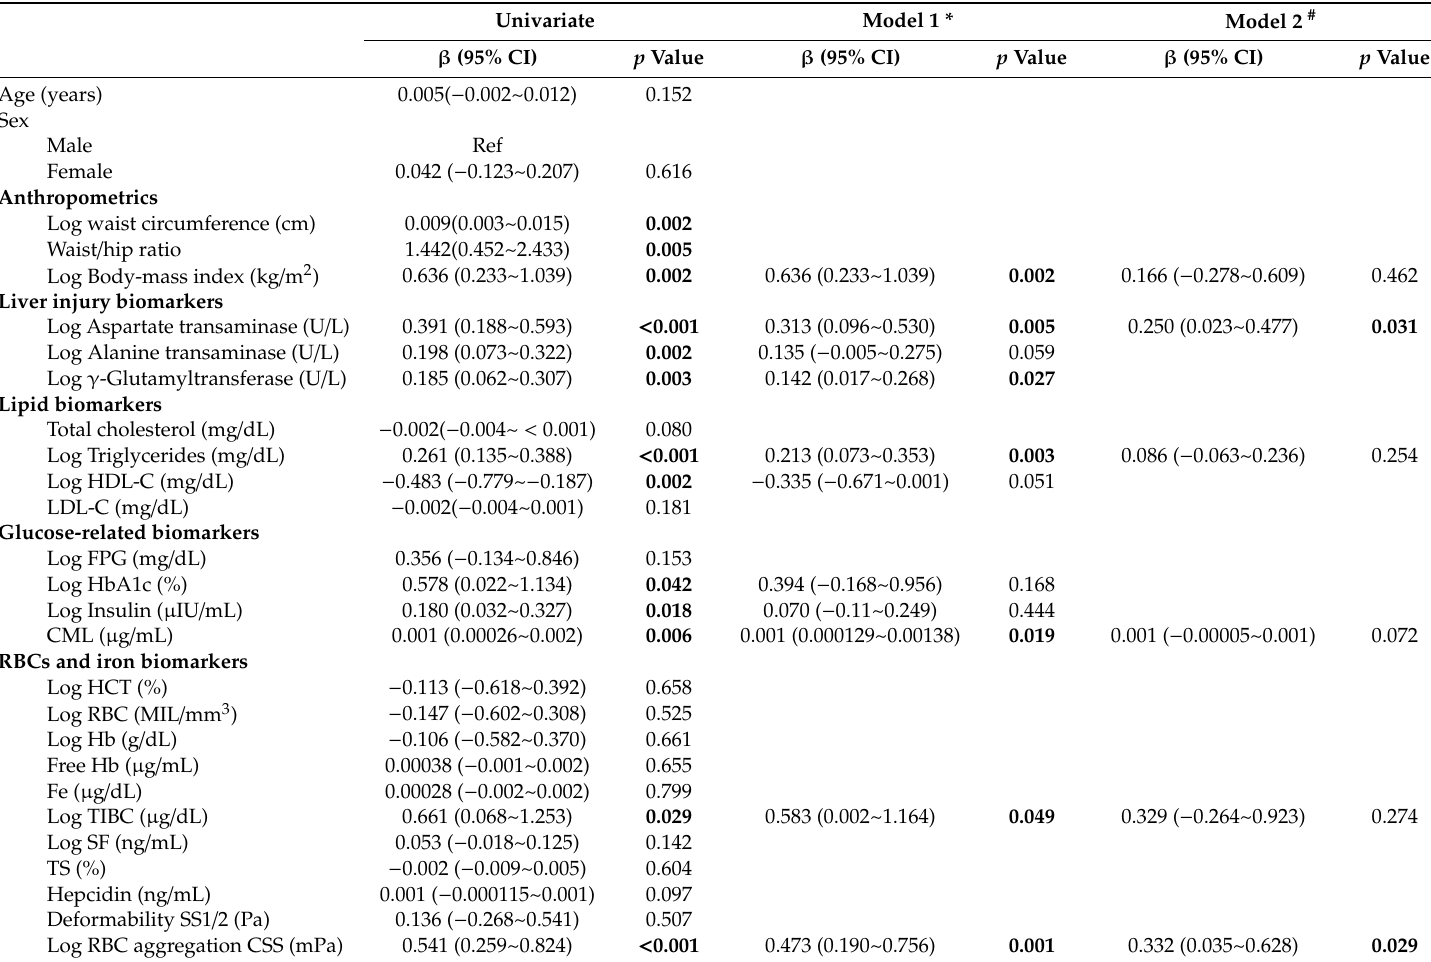
Table 2. Multivariate linear regression of soluble CD163 levels and selected anthropometric, inflammation, lipid, glucose, and iron-related biomarkers ( N =